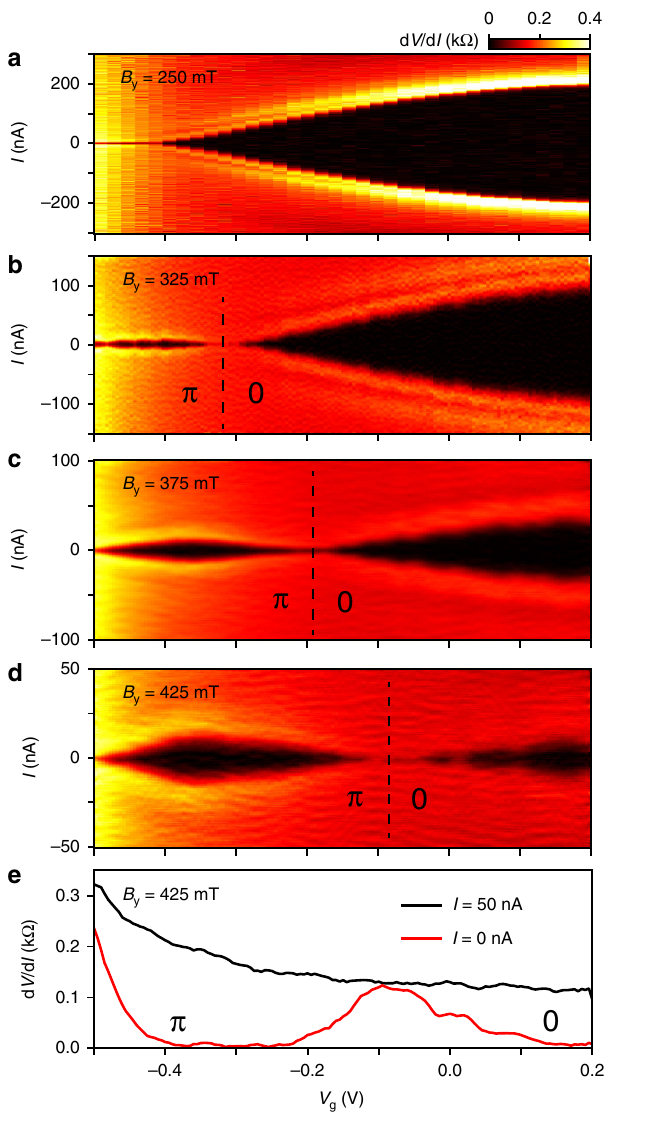
Fig. 3 Gate-driven 0 – π transitions. a – d d V /d I as a function of I and V g for several B y as indicated. From B y = 325 mT onward, a gate-driven 0 − π transition becomes evident, characterized by a re-emergence of I s with decreasing V g . As expected, the transition shifts to higher gate voltages with increasing B y (see Supplementary Note 6 for sweeps at additional values of the magnetic fi eld). e Line-cuts through panel d at I = 50 nA (black) and I = 0 nA (red). The low bias trace reveals the 0 − π transition whereas the high bias trace shows a monotonic behavior magnetic fi eld, B y = 325 mT, I s reveals a markedly different behavior, whereby the supercurrent fi rst decreases and then (at V g = − 0.32 V) shows a clear revival, indicative of a gate-driven 0 – π transition, where the resonance condition ( E Z = π E Th ) is achieved by tuning the electron density. Increasing B y further, continuously moves the transition point to higher gate voltages (larger density), perfectly in line with expectations for a 0 – π transition. Figure 3e shows two line-cuts from Fig. 3d. At zero current bias, d V /d I shows a clear peak, indicative of a re-entrance of the supercurrent due to the the 0 – π transition. However, at high bias, d V /d I increases monotonically, similar to the response at zero magnetic fi eld. This eliminates trivial interference effects as an explanation for the supercurrent modulation, where one would expect a correlation between the two curves 35,41,42 .